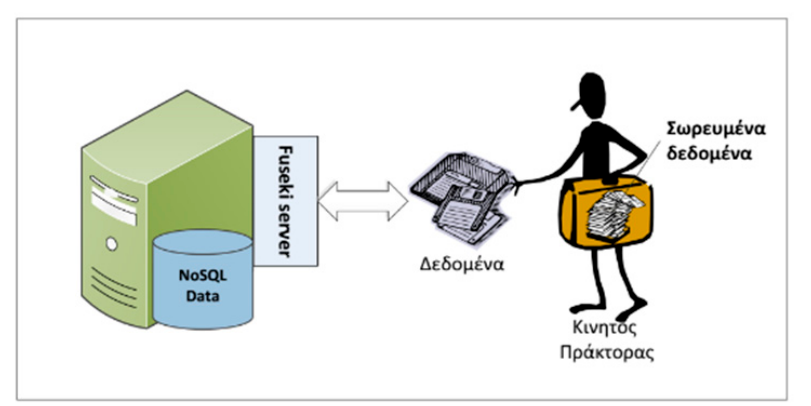
Figure 4. The JADE-based Platform architecture.